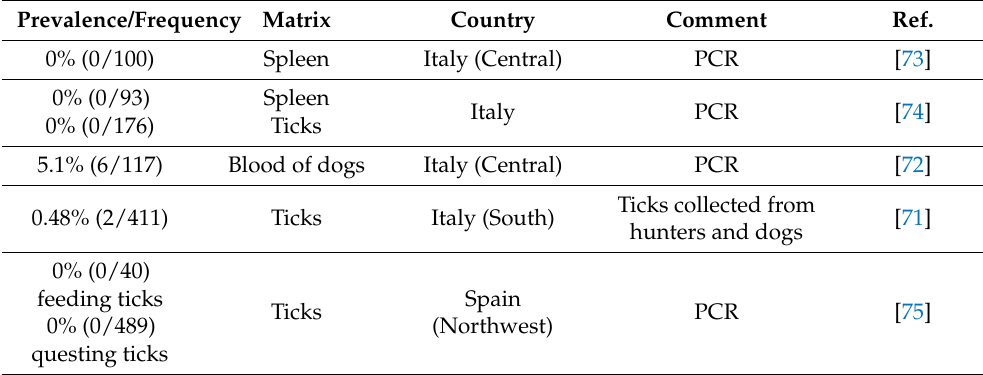
Table 5. Presence of Coxiella burnetii or antibodies in wild boar or in vectors associated with wild boar, according to country and continent,